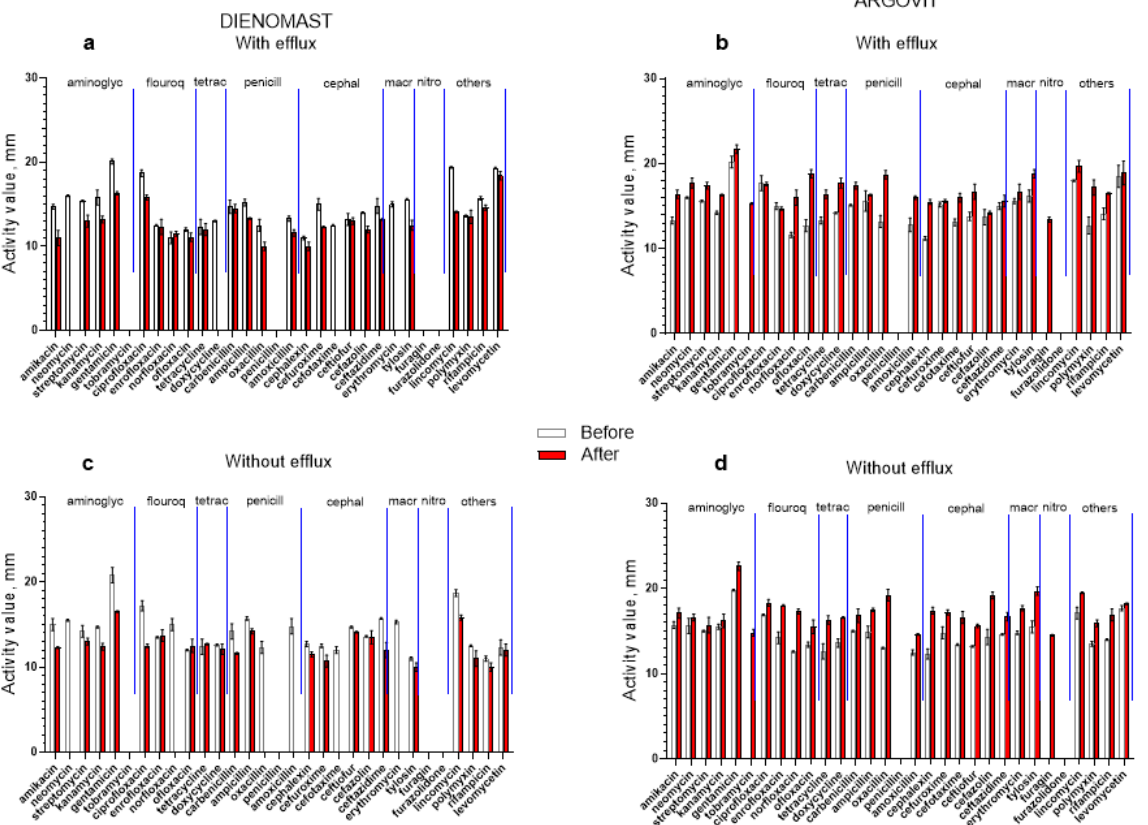
Figure 3. Susceptibility of E. coli to 31 antibiotics before (white columns) and after (red columns) treatment with Dienomast TM ( a , c ) and Argovit-C TM ( b , d ). Isolates with ( a , b ) and without ( c , d ) efflux effect.